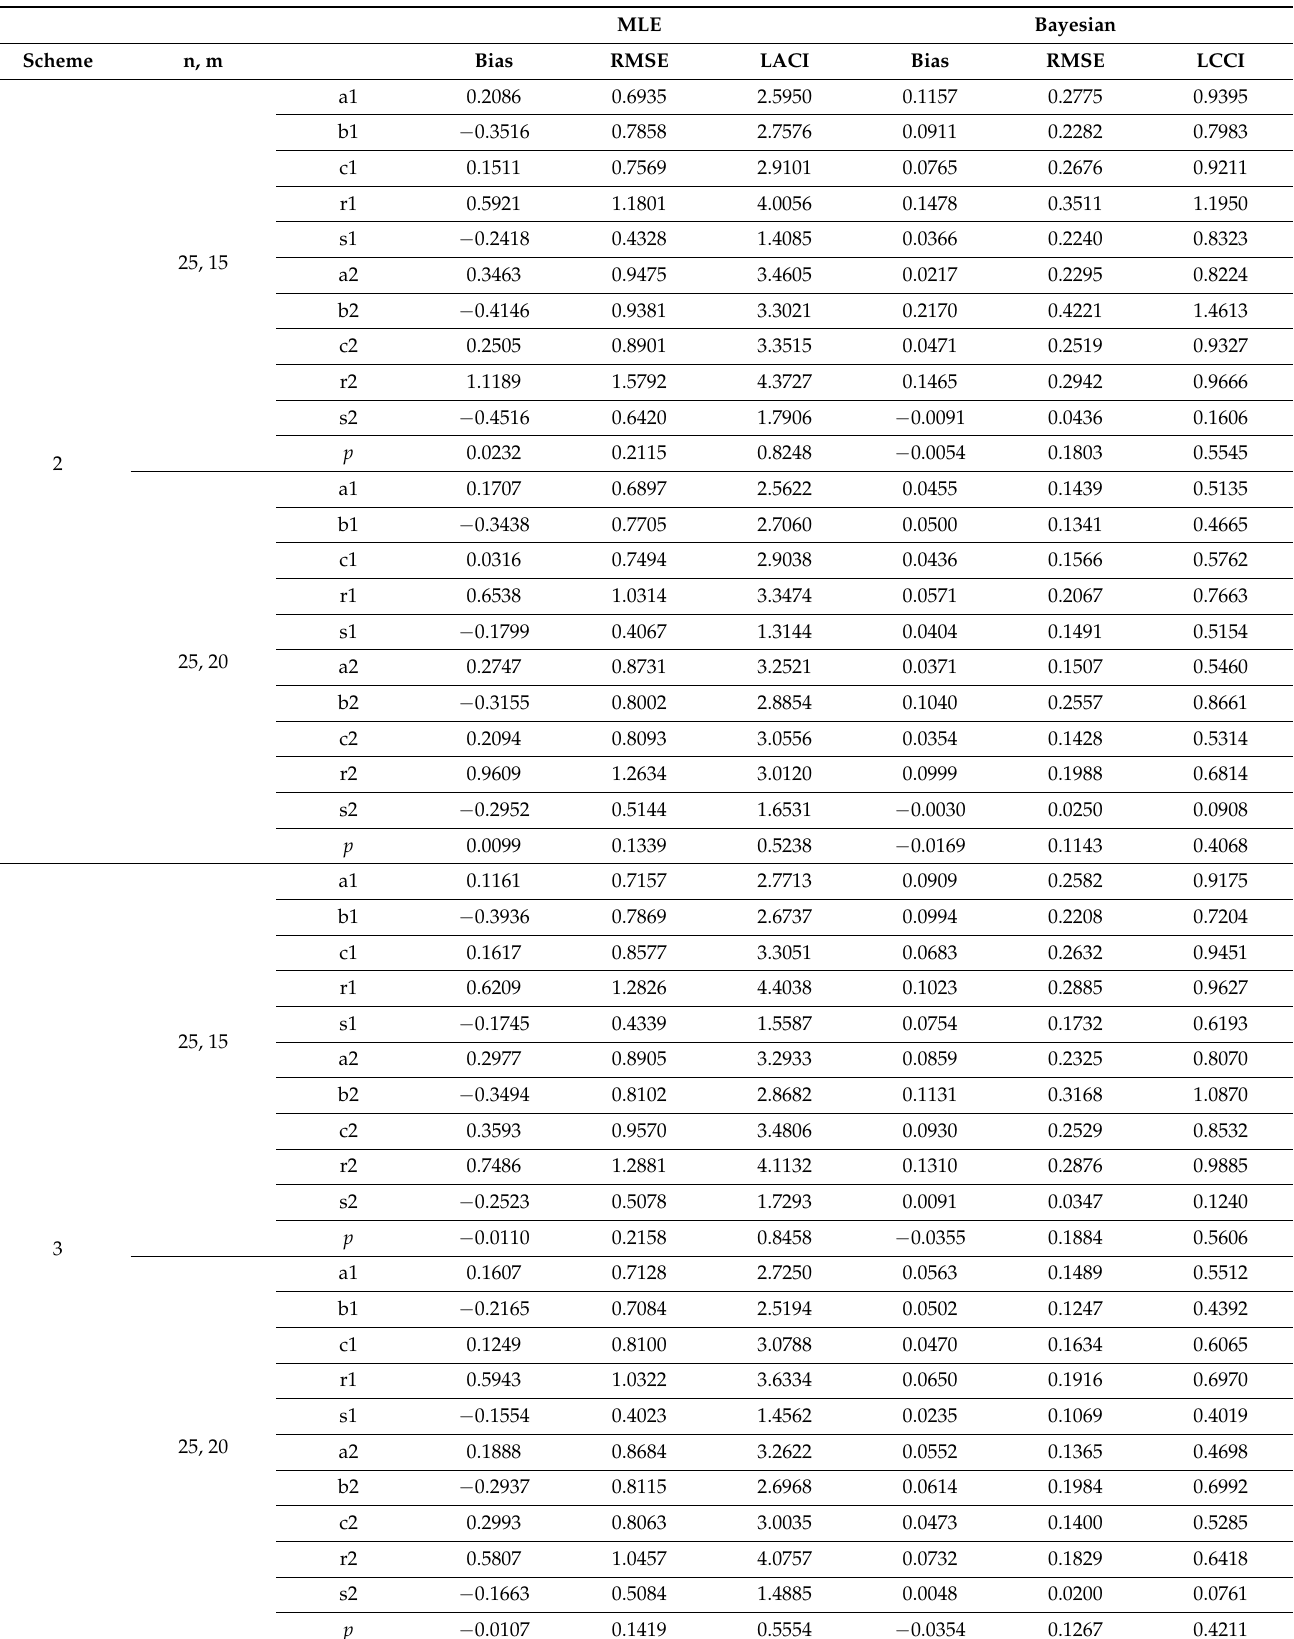
Table 3. Bias, RMSE and length of CI for the MLE and Bayesian estimates of the parameters are presented for different schemes: Case 1 and n =